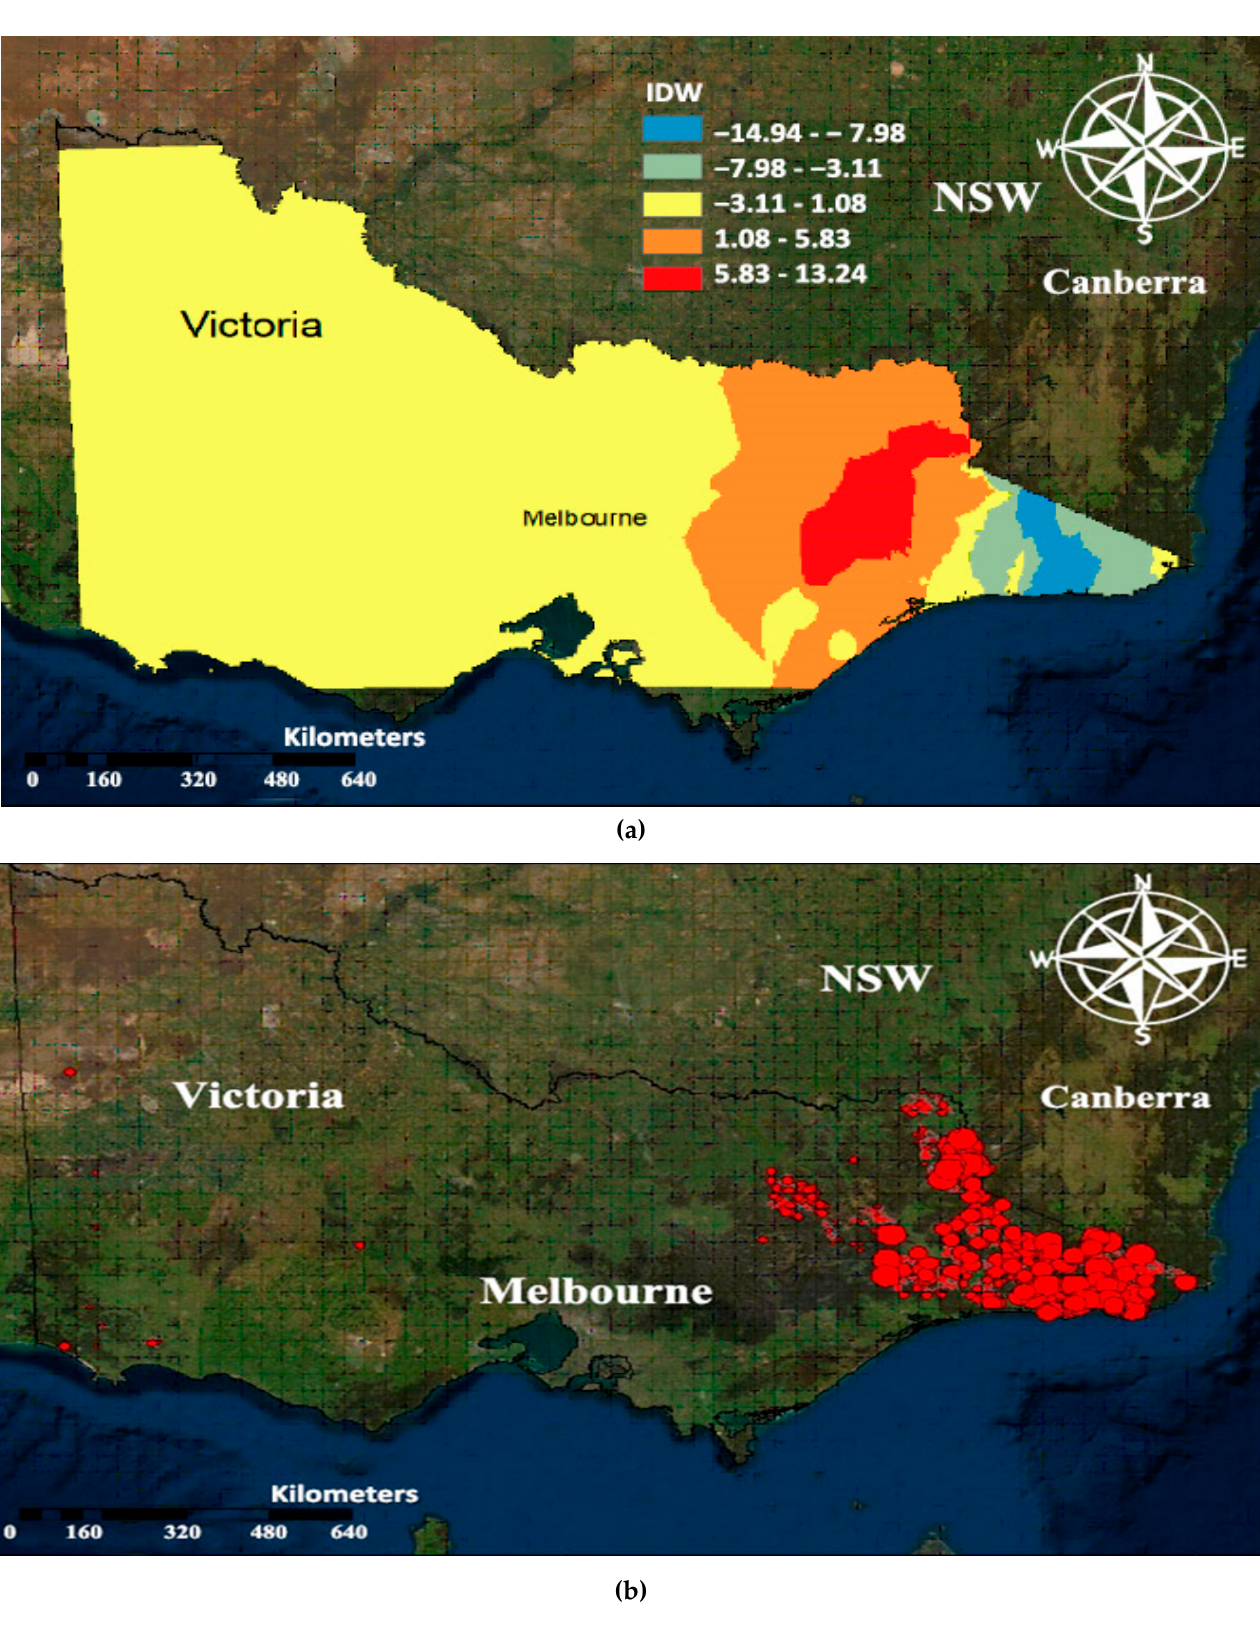
Figure 14. IDW maps and bushfire hotspots of Victoria ( a ) IDW map after identification of Hotspots, ( b ) Final bush fire hotspots in the State of Victoria.